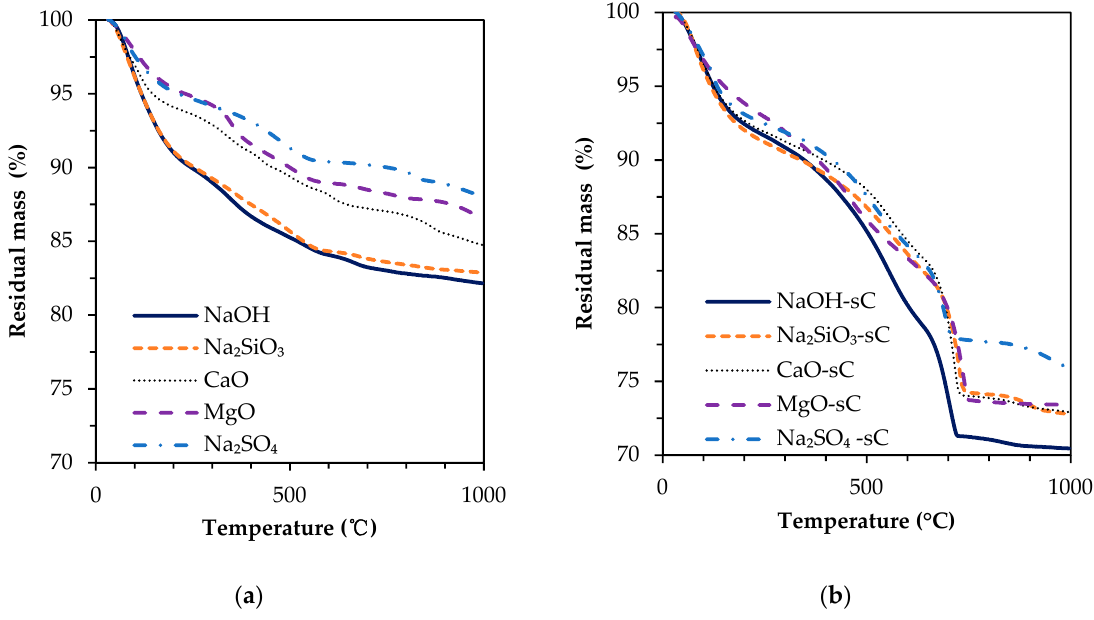
Figure 5. Residual mass curves of alkali-activated slag samples: ( a ) carbonated and ( b ) uncar- bonated.